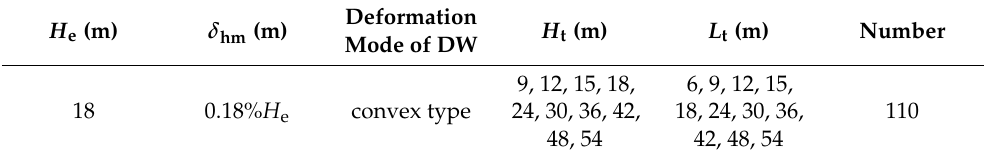
Table 2. Numerical simulation conditions.